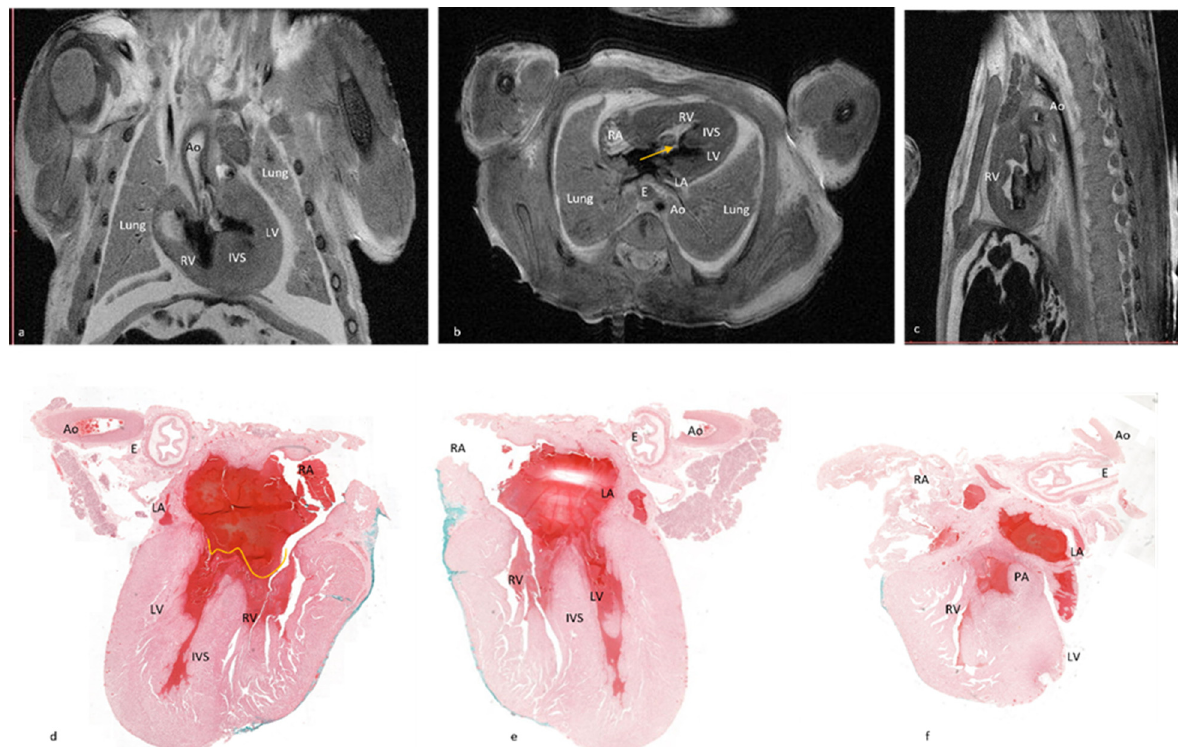
Figure 5. Presenting comparative images of the pm-MRI and microscopy of case No. 11. Note the small-sized left ventricle ( a , b ) and overriding aorta ( a ). ( c ) Sagittal section through mediastinum. Complete atrioventricular canal was observed on both examination methods. On the pm-MRI image ( b ), yellow arrow marks the ventricular septal defect and atrial septal defect. On the microscopic image ( d ), the yellow line highlights the atrioventricular valve passing over the ventricular septal defect. Interatrial septum is also absent. ( d ) The 4CCD heart section and hematoxylin-eosin stain, 0.4 × . ( e , f ) The 4CCD heart section and hematoxylin-eosin stain, 0.5 ×